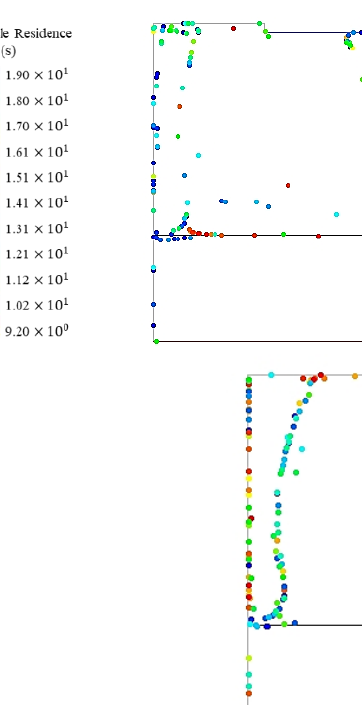
Figure 8. Effect of electrode vibration frequency on inclusion removal ratio with different diameter.